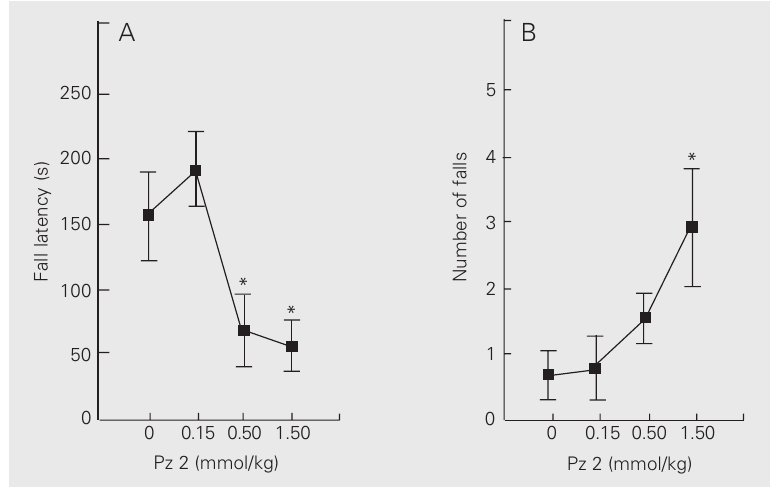
Figure 2. Effects of Pz 2 administration on the latency for the first fall (A) and on the number of falls (B) from the rotarod. Data are reported as means ± SEM for N = 8 animals per group. *P < 0.05 compared with vehicle group (Student-Newman-Keuls